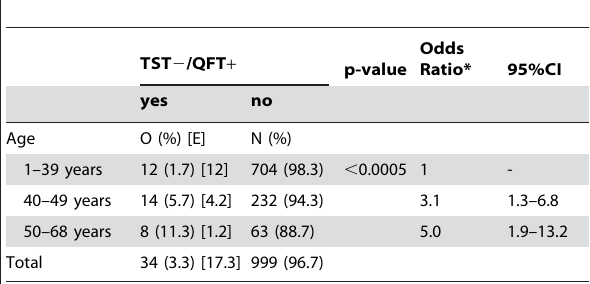
Table 5. Age as putative cause for TST 2 /QFT + Discordance.